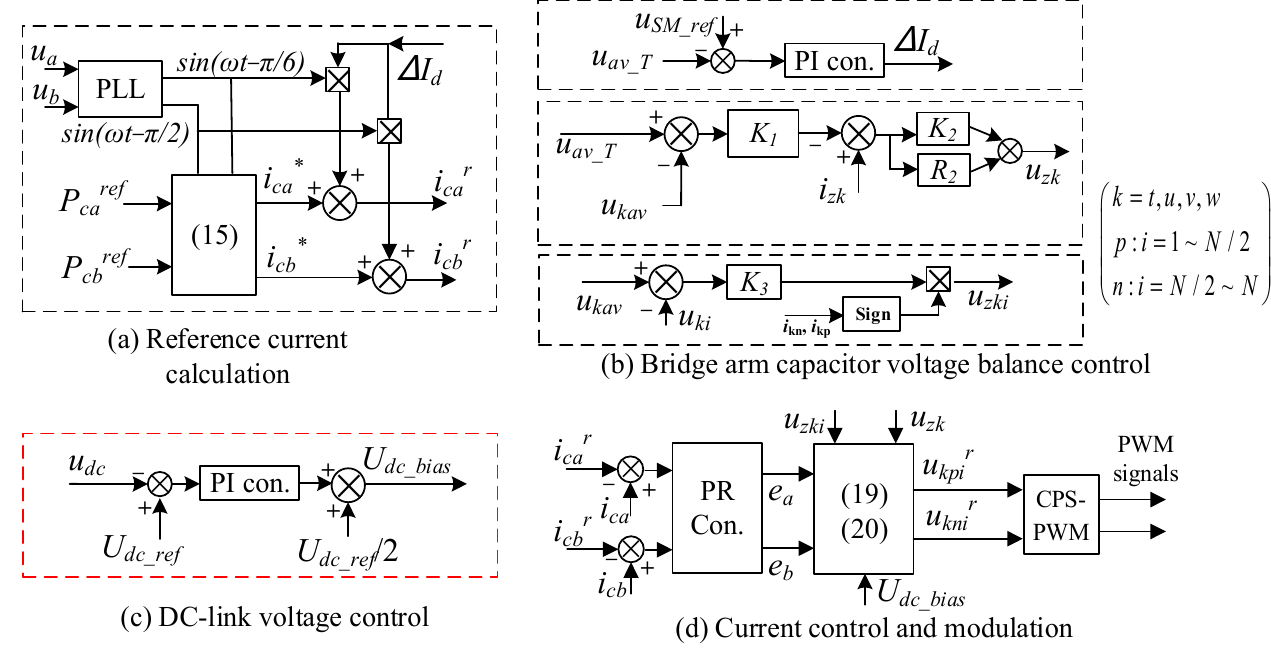
Figure 3. System control block diagram of MMC-PWM